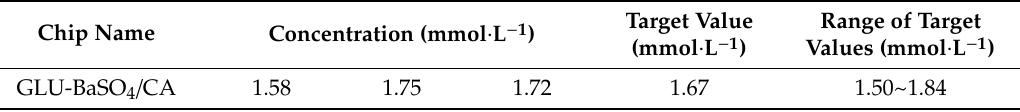
Table 5. Accuracy of BaSO 4 /CA detection chip.